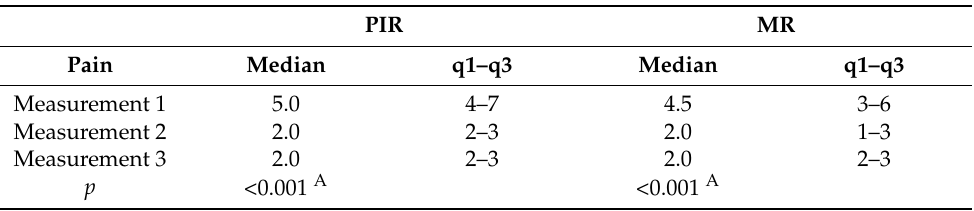
Table 6. Intensity of spontaneous pain in the masticatory muscles in the VAS score, assessed during the first examination and follow-up in group I (PIR) and group II (MR).